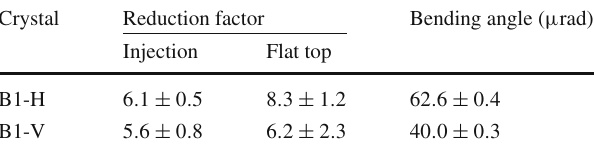
Table 3 Reduction factors of local losses in channeling and crystal bending angles computed from different data sets. The average values are presented with the error evaluated as the RMS of available data sets. Bending angles are computed as averages of measurements at injection